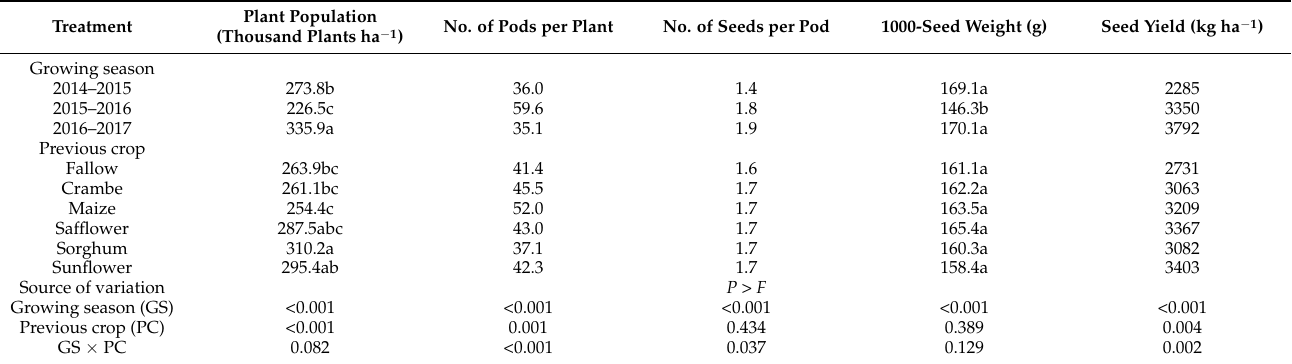
Table 4. Final plant population, number of pods per plant, number of seeds per pod, 1000-seed weight, and seed yield of spring–summer soybean crop following different fall–winter crops in three growing season, and analyses of